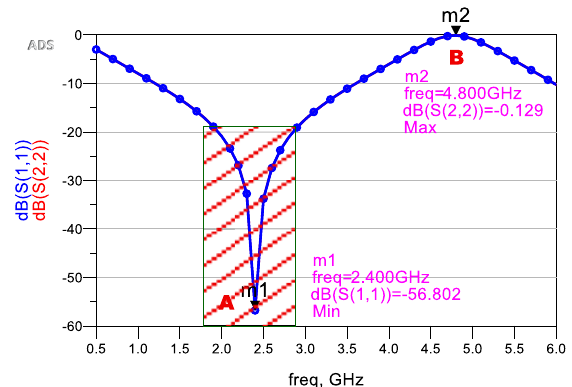
Fig. 5. S-parameters results of the proposed biasing network (S 11 and S 22 )